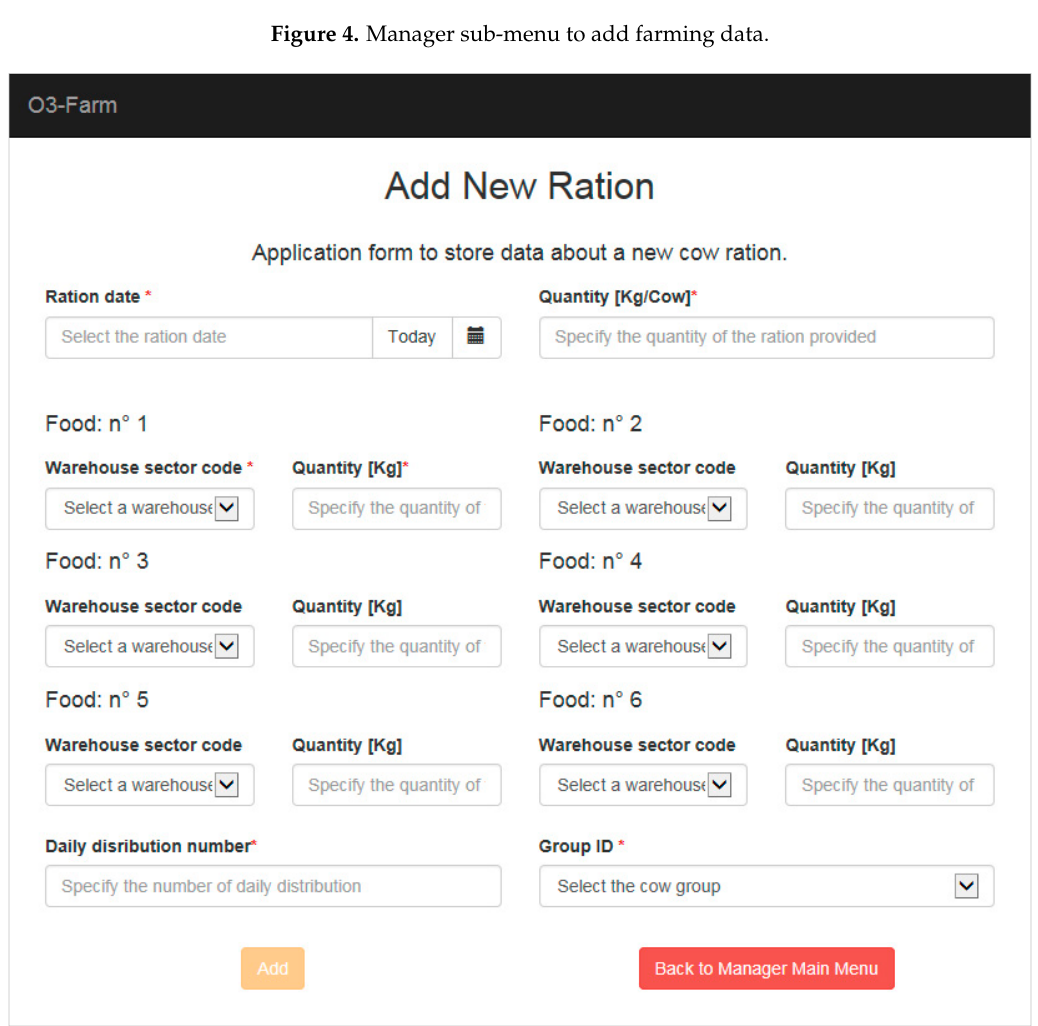
Figure 5. Application form that a manager can use to store a new ration for a specific group of cows.